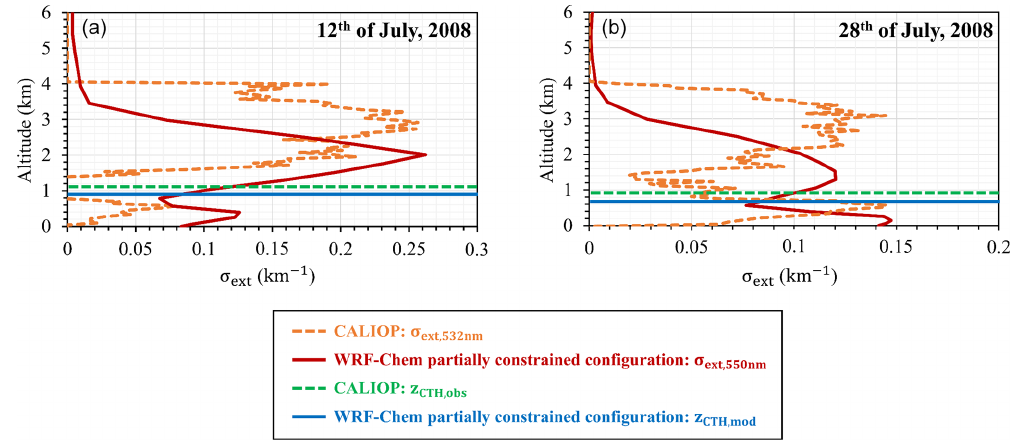
Figure 9. Mean vertical profiles of the aerosol extinction coefficients retrieved by CALIOP at 532nm (orange dotted lines) and simulated with the WRF-Chem partially constrained configuration at 550nm (red solid lines) under the CALIOP track inside the study area (0–15 ◦ E, 15–5 ◦ S) for 12 July 2008 (a) and 28 July 2008 (b) . Mean cloud top heights retrieved by CALIOP (green dotted lines) and simulated with the WRF-Chem partially constrained configuration (blue solid lines) are also incorporated into the graphics. CALIOP data, initially at a horizontal spatial resolution of 5 × 5km 2 , were aggregated onto the WRF-Chem mesh (30 × 30km 2 ), and only the coincident pixels were selected for the comparison